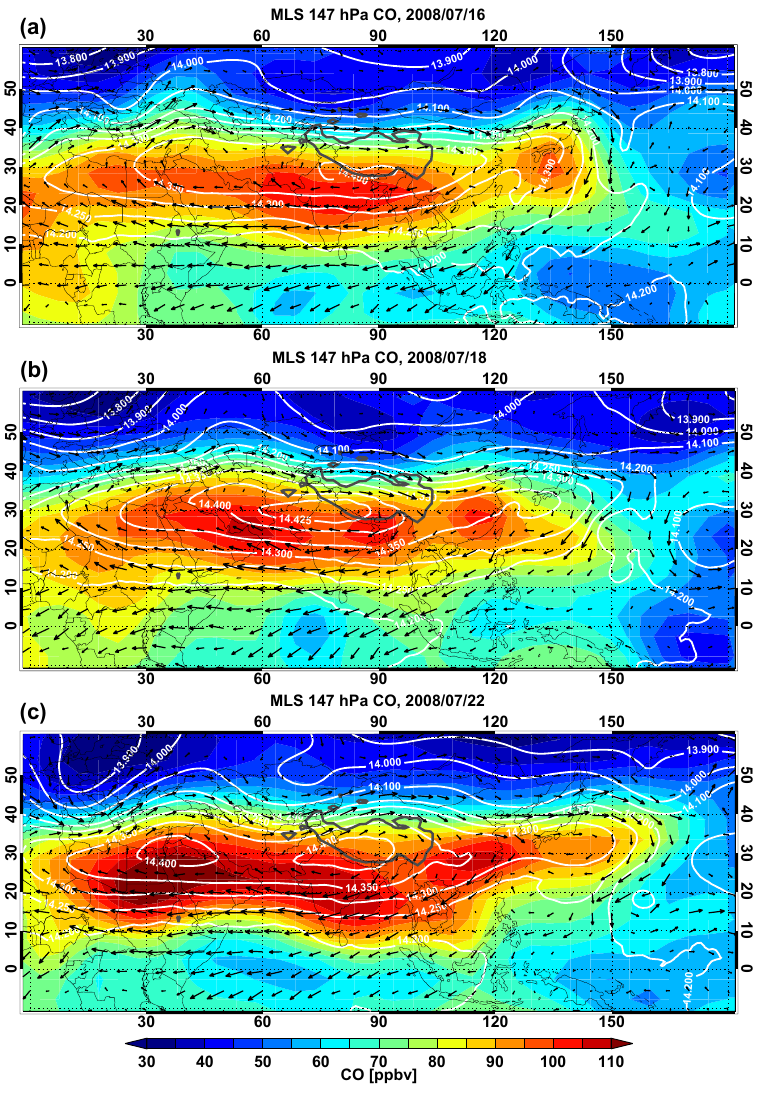
Figure 5. Daily maps of MLS CO mixing ratio at 147hPa (color shading) on (a) 16 July, (b) 18 July, and (c) 22 July 2008. Dynamical fields of GPH (white contours) and horizontal winds (black arrows) are superimposed. Maps are interpolated using the natural neighbor algorithm (Watson, 1992) to 5 ◦ × 5 ◦ longitude–latitude grids. The location of the Tibetan Plateau (using 3km elevation) is also shown in the maps (thick